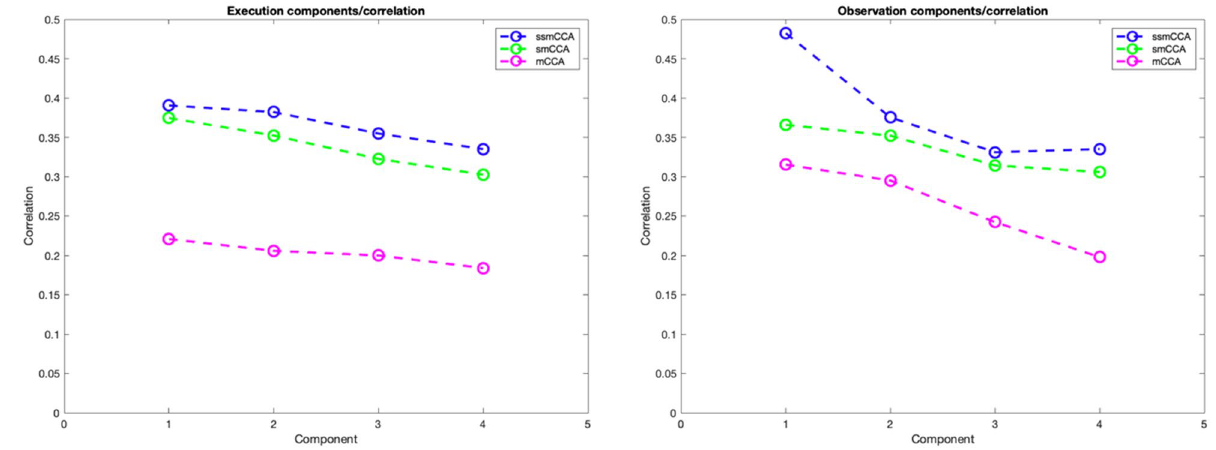
Figure 6. Correlations by their corresponding components resulting from EEG-fNIRS fusion applying mCCA, smCCA and